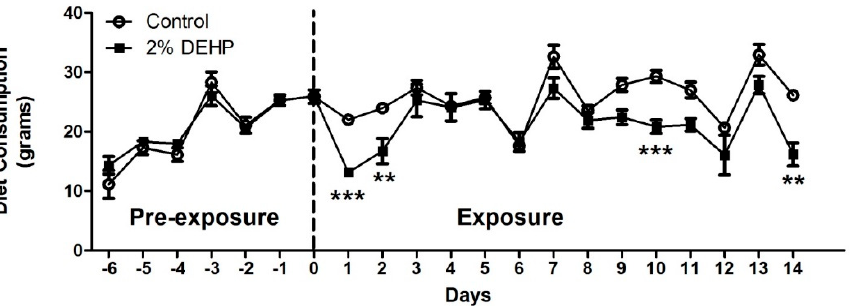
Figure 2. Effects of 2% DEHP exposure on diet consumption throughout the study duration (7 day pre-exposure and 14 day exposure) ( n = 7 per group). Significant differences are indicated with; ** p < 0.01 and *** p < 0.0001.